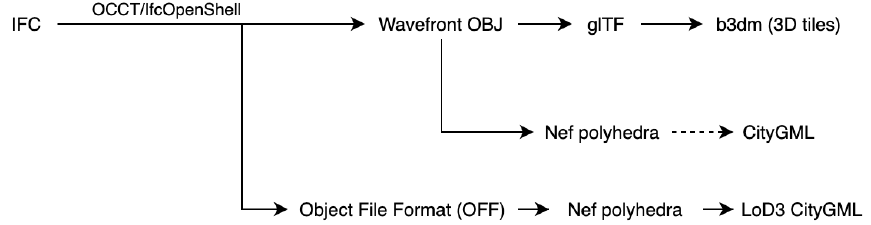
Figure 1. OCCT/IfcOpenShell in BIM-to-GIS data conversion by previous studies.